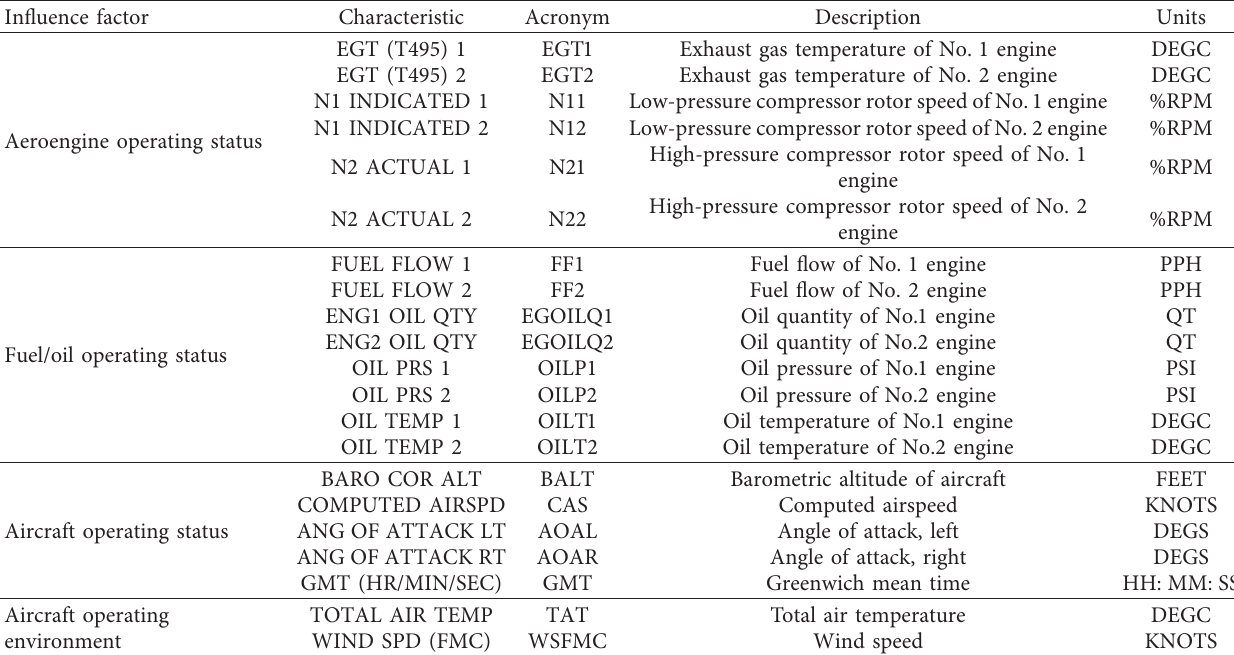
Table 1: 4 types of factors and